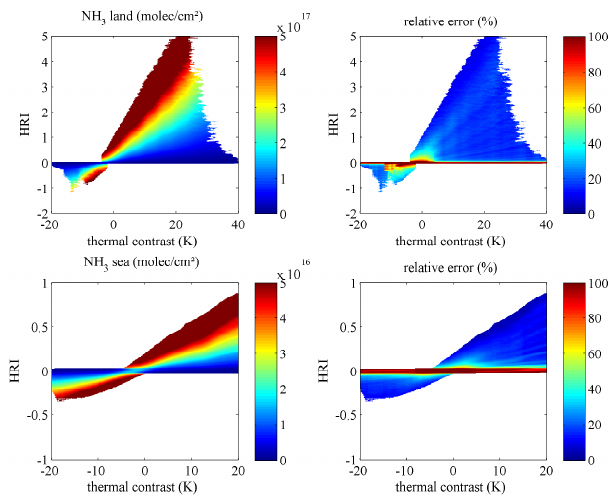
Fig. 4. Look-up tables used to convert HRI into NH 3 total columns through the thermal contrast (left panels) with the associated re- trieval error (right panels), above land (top panels) and sea (bot- tom panels). The tables are built from about 450000 simulated IASI spectra above land and about 116000 above sea; see text for